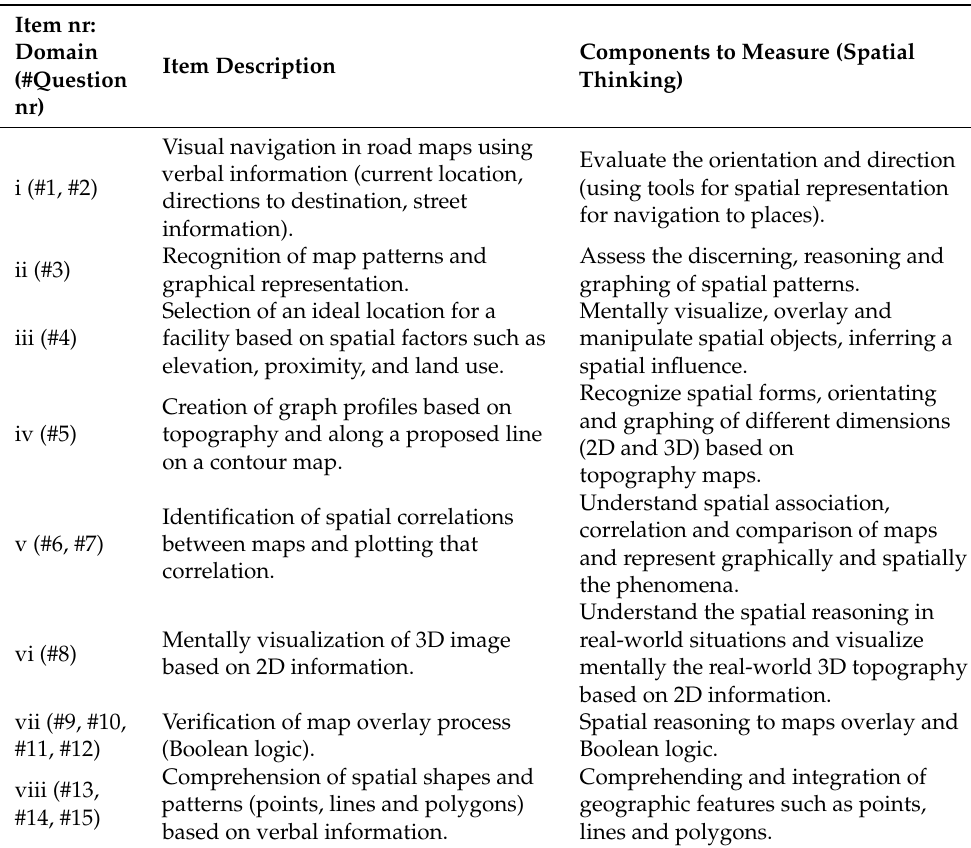
Table 2. Item description based on item number and components to measure spatial thinking (adapted from